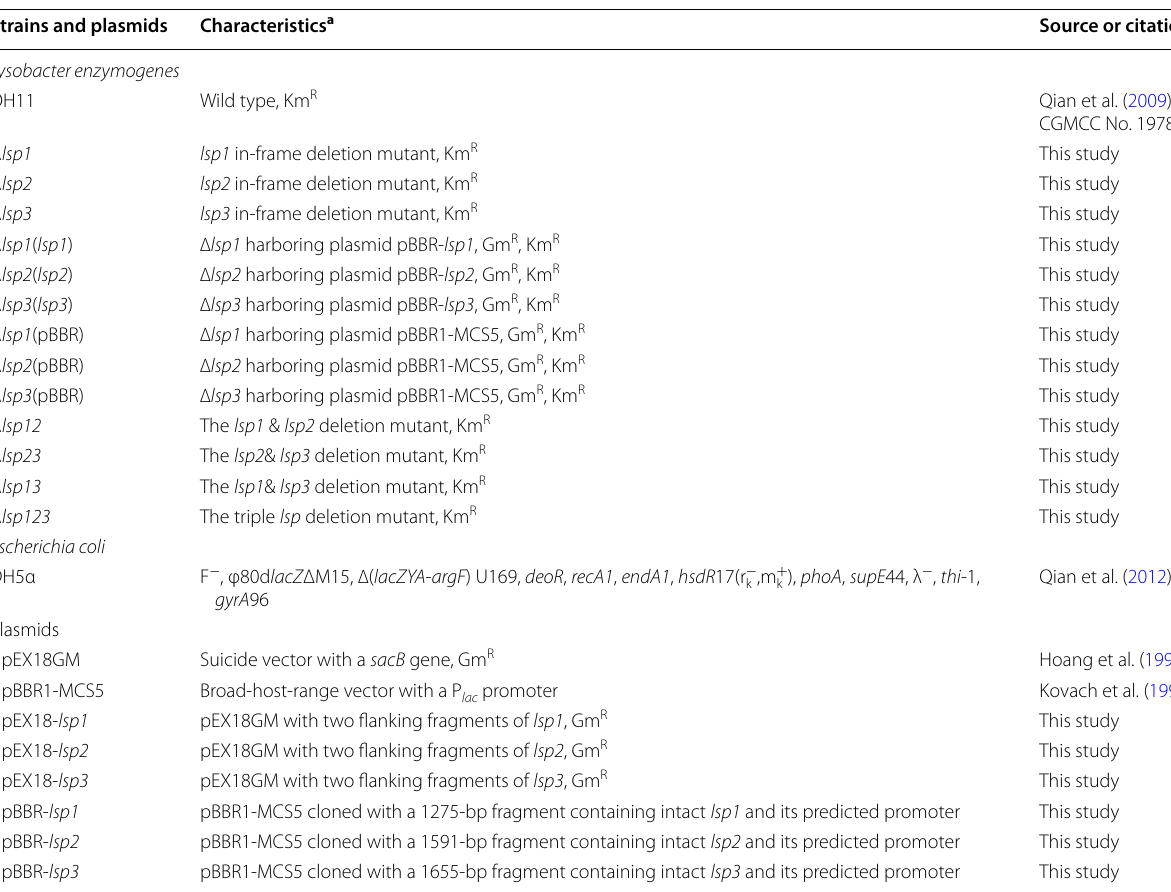
a Km R , Gm R Kanamycin-, Gentamicin-, respectively =